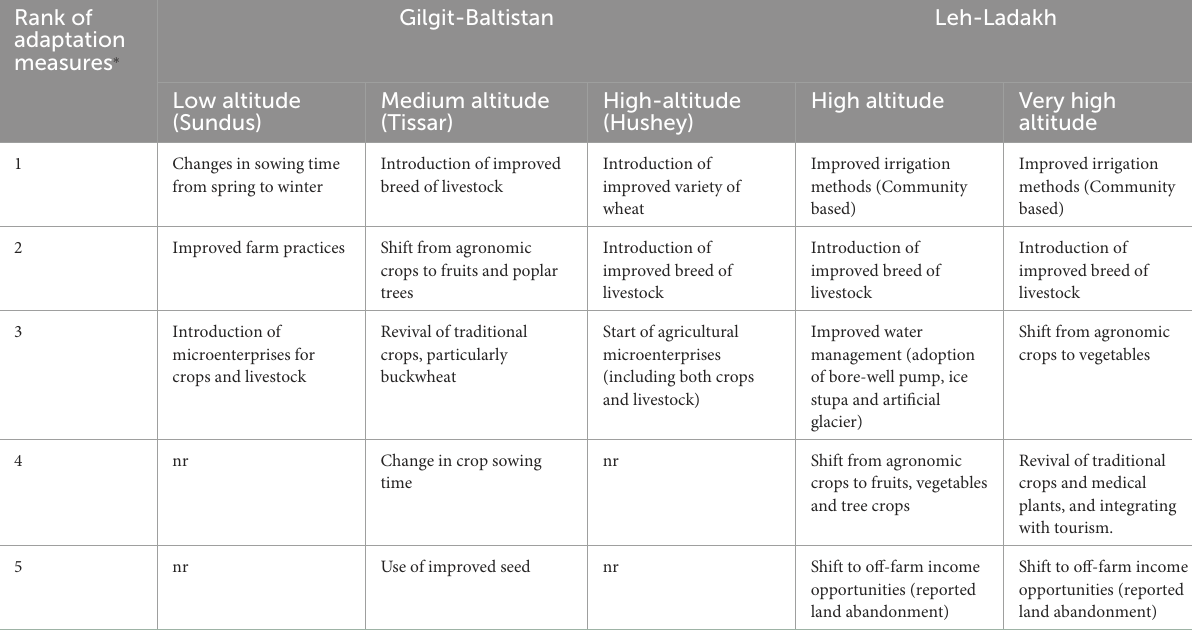
TABLE 5 Local adaptation measures to cope with climate change and water variability. Rank of